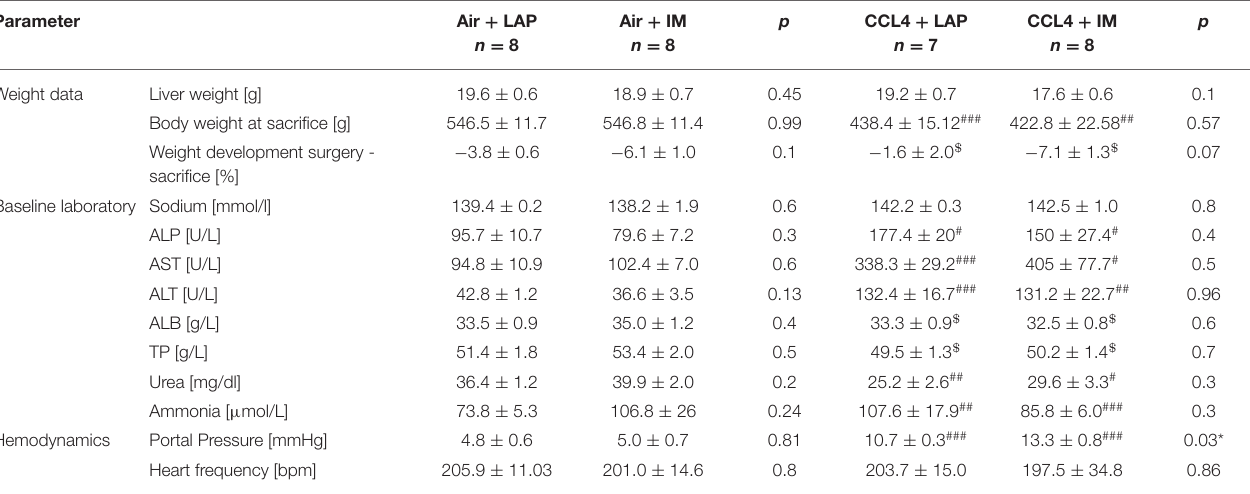
TABLE 1C | General characteristics and clinical data of rats receiving AIR/CCL4 at sacrifice 2 days after IM/LAP. Parameter